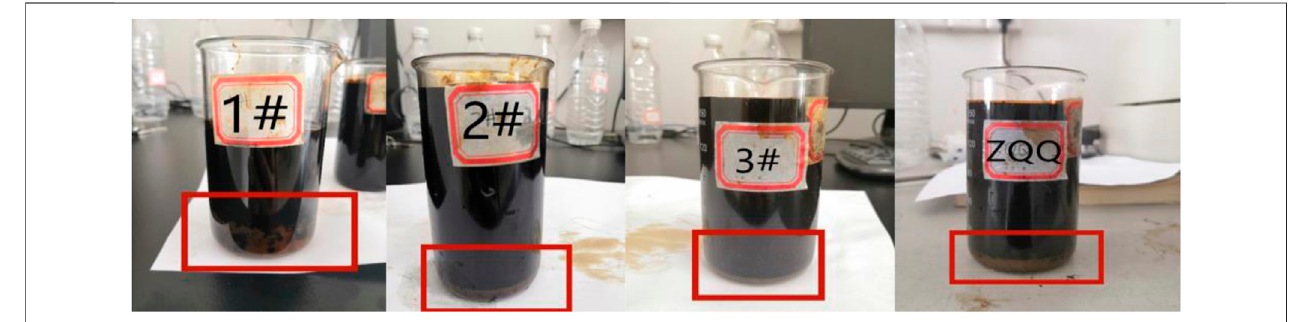
FIGURE 4 | The emulsion standing for 1 h.